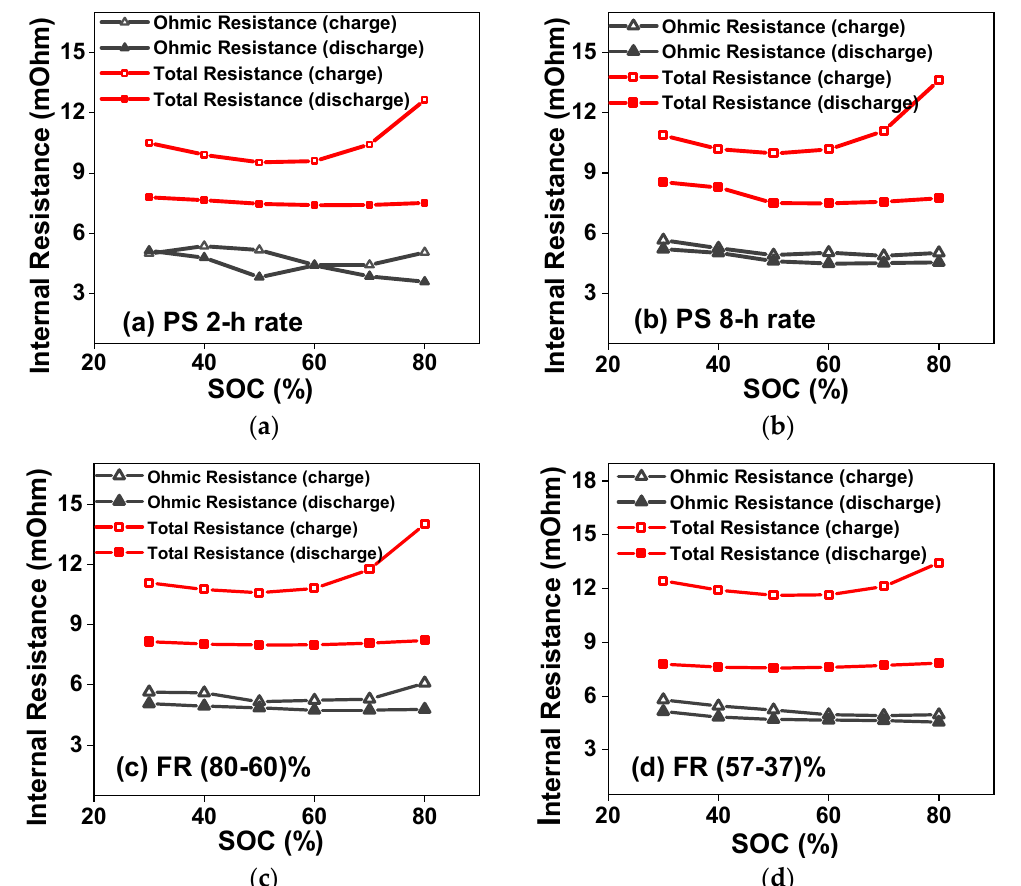
Figure 8. Internal resistance vs. SOC (%) for four duty cycles. ( a ) peak shaving 2-h rate ( b ) peak shaving 8-h rate ( c ) frequency regulation (80–60)% and ( d ) frequency regulation